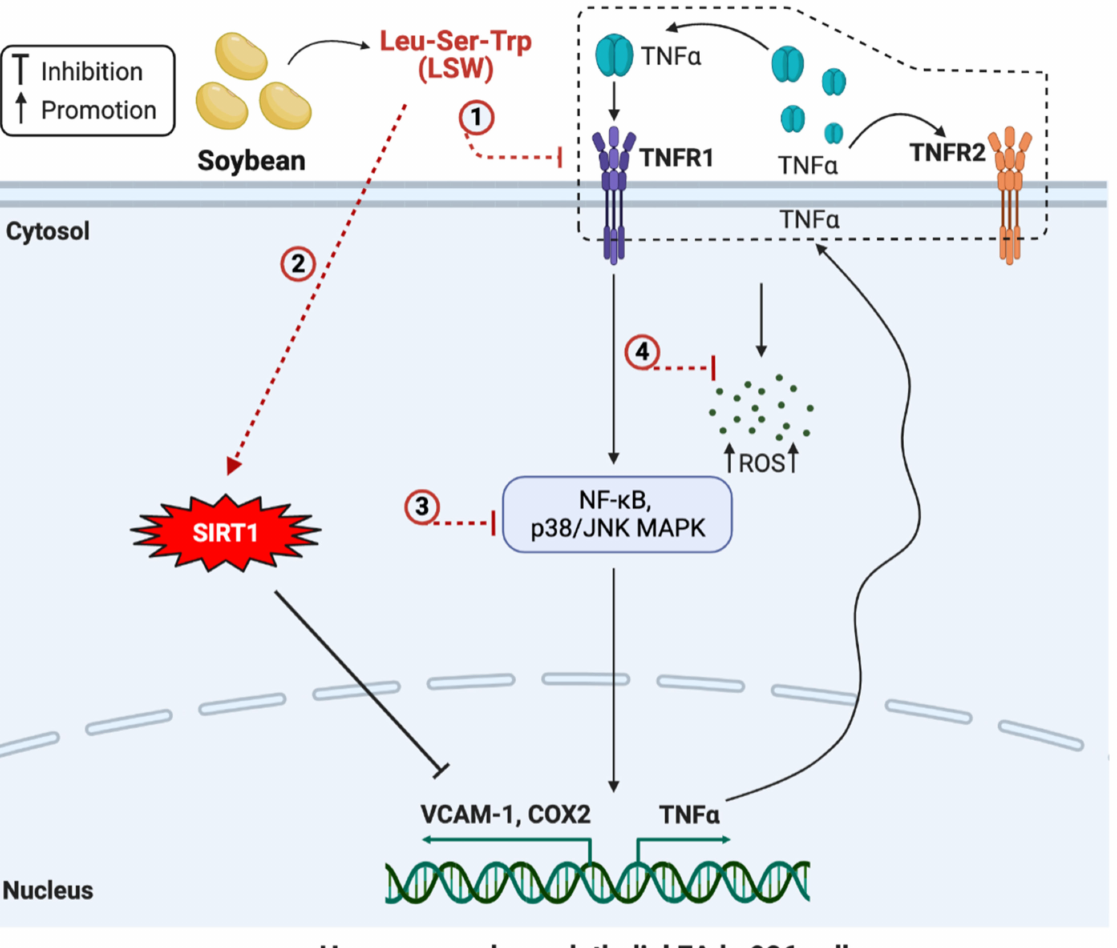
Figure 7. Mechanisms of action of LSW in mitigating TNF α -induced inflammation and oxidative stress in EA.hy926 cells. LSW might promote or inhibit cellular biological effects directly or indirectly (dash line, not necessarily needed to enter the